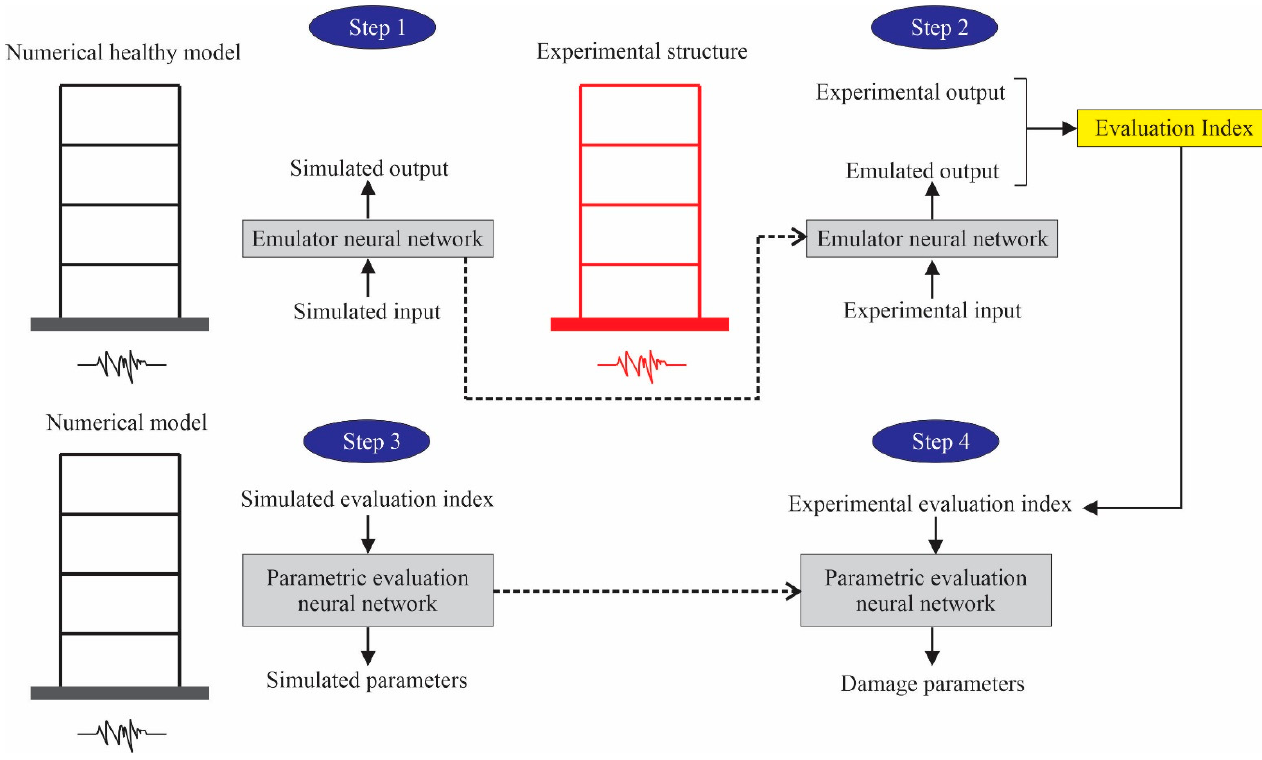
Figure 10. The overall procedure of the application of nonparametric emulators for SHM. Table 1. Inputs and outputs of nonparametric surrogate models.